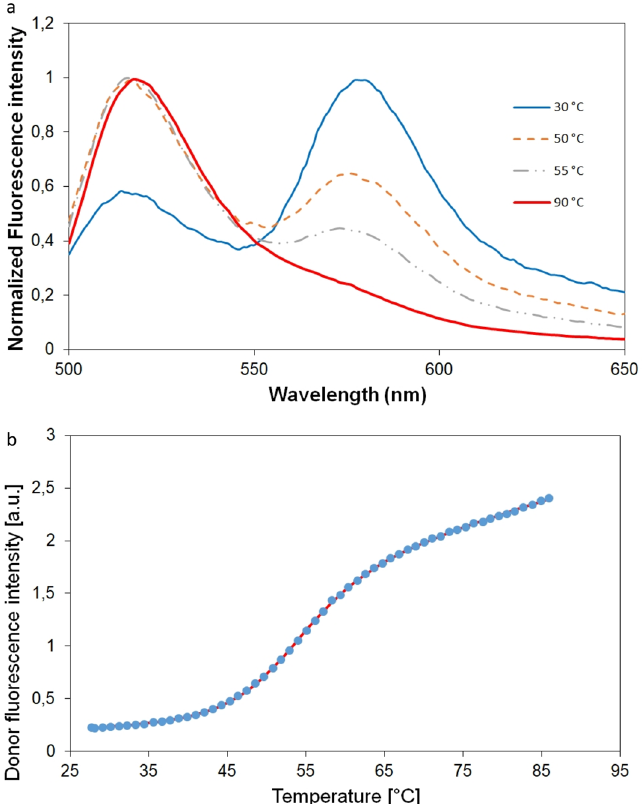
Figure 1. ( a ) Fluorescence spectra of HepB labeled by a FRET pair of FAM and TAMRA in K-phosphate buffer containing 140 mM K + ion at few selected temperatures. ( b ) The donor fluorescence intensity vs. temperature. The line represents the fitting of Eq. (6).